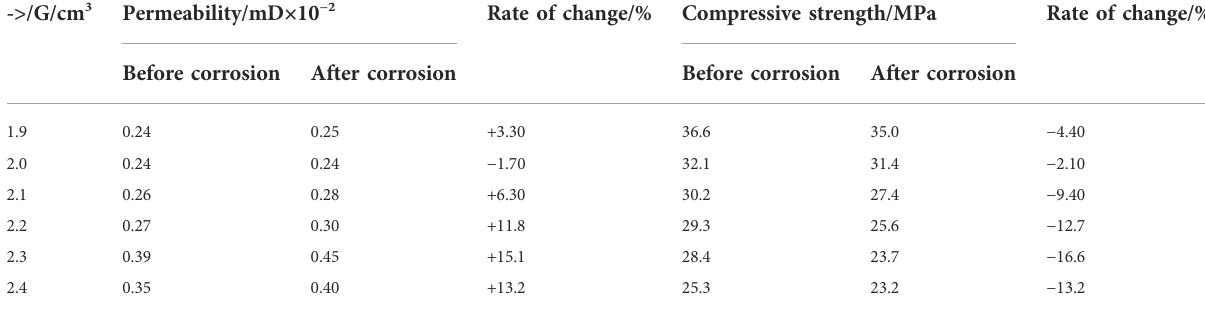
TABLE 7 Performance change of high density BFs-HA-composite emulsion cement paste before and after corrosion. ->/G/cm 3 Permeability/mD×10 − 2 Rate of change/% Compressive strength/MPa Rate of change/% After